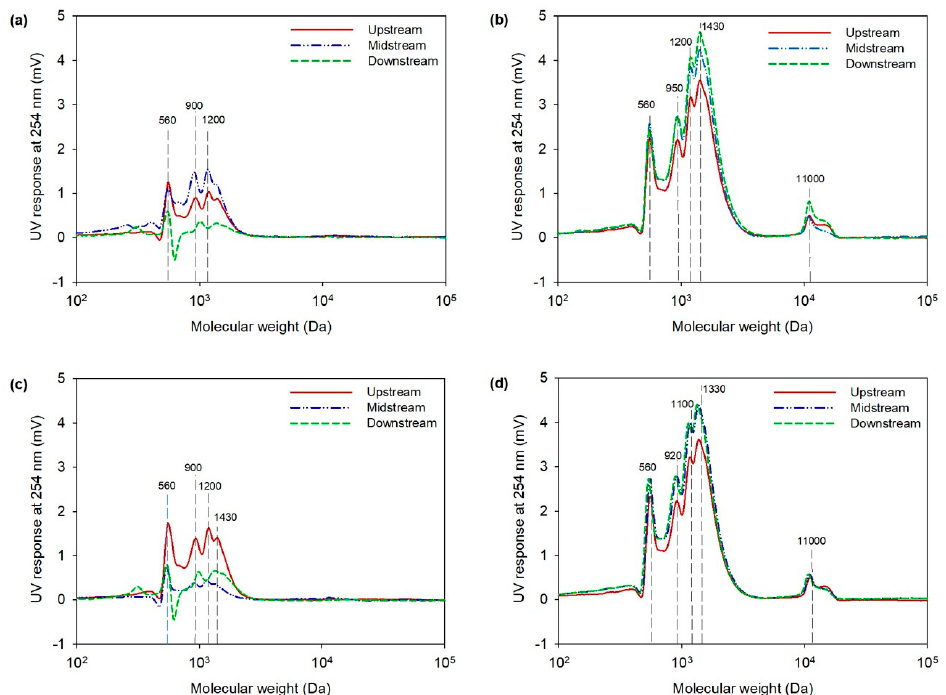
Figure 4. Molecular weight distribution of dissolved organic matter (DOMs) at each sampling points. ( a ) Before rainfall in Event 1, ( b ) after rainfall in Event 1, ( c ) before rainfall in Event 2, ( d ) after rainfall in Event 2.